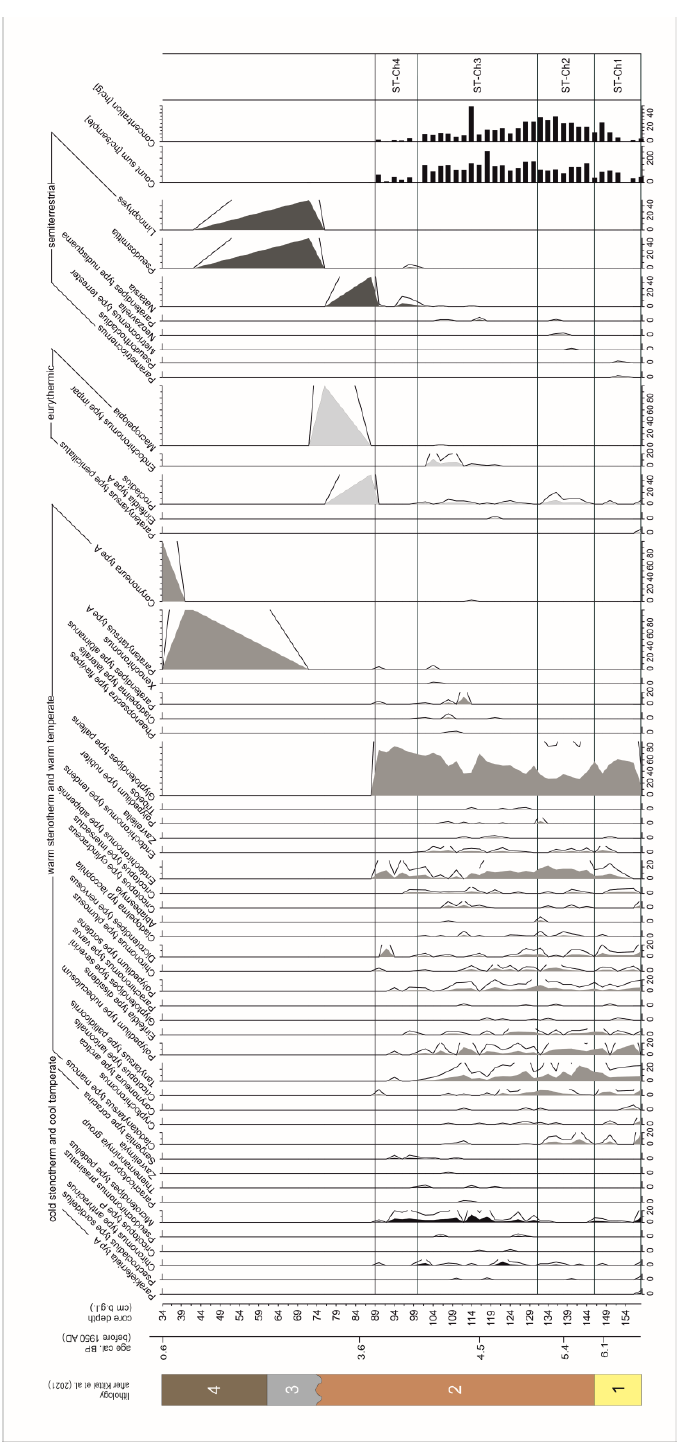
Figure 2. Chironomidae stratigraphic diagram presenting the main chironomid taxa. Taxa are grouped according to summer temperature and lake depth preferences. Exaggeration is with a three times multiplier. Lithology: 1 - sand and gravel with organic mud and plant detritus; 2 - coarse detritus gyttja; 3 - carbonate sandy organic mud; 4 - peaty organic mud with sandy admixtures.